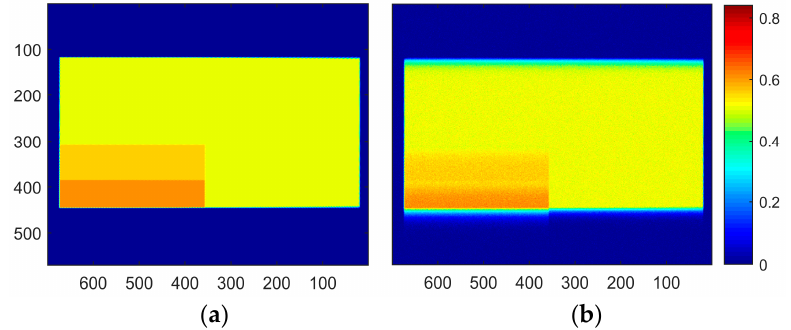
Figure 7. ( a ) Sharp image that is to be recovered in polar coordinates, and ( b ) blurred Gate 2 image (as in Figure 5c) in polar coordinates. Colors represent the intensity captured in the Gate 2 image. The image x-axis is pixels in the r -direction, and the y-axis is pixels in the θ -direction. Rotation is downward; images are in polar coordinates.